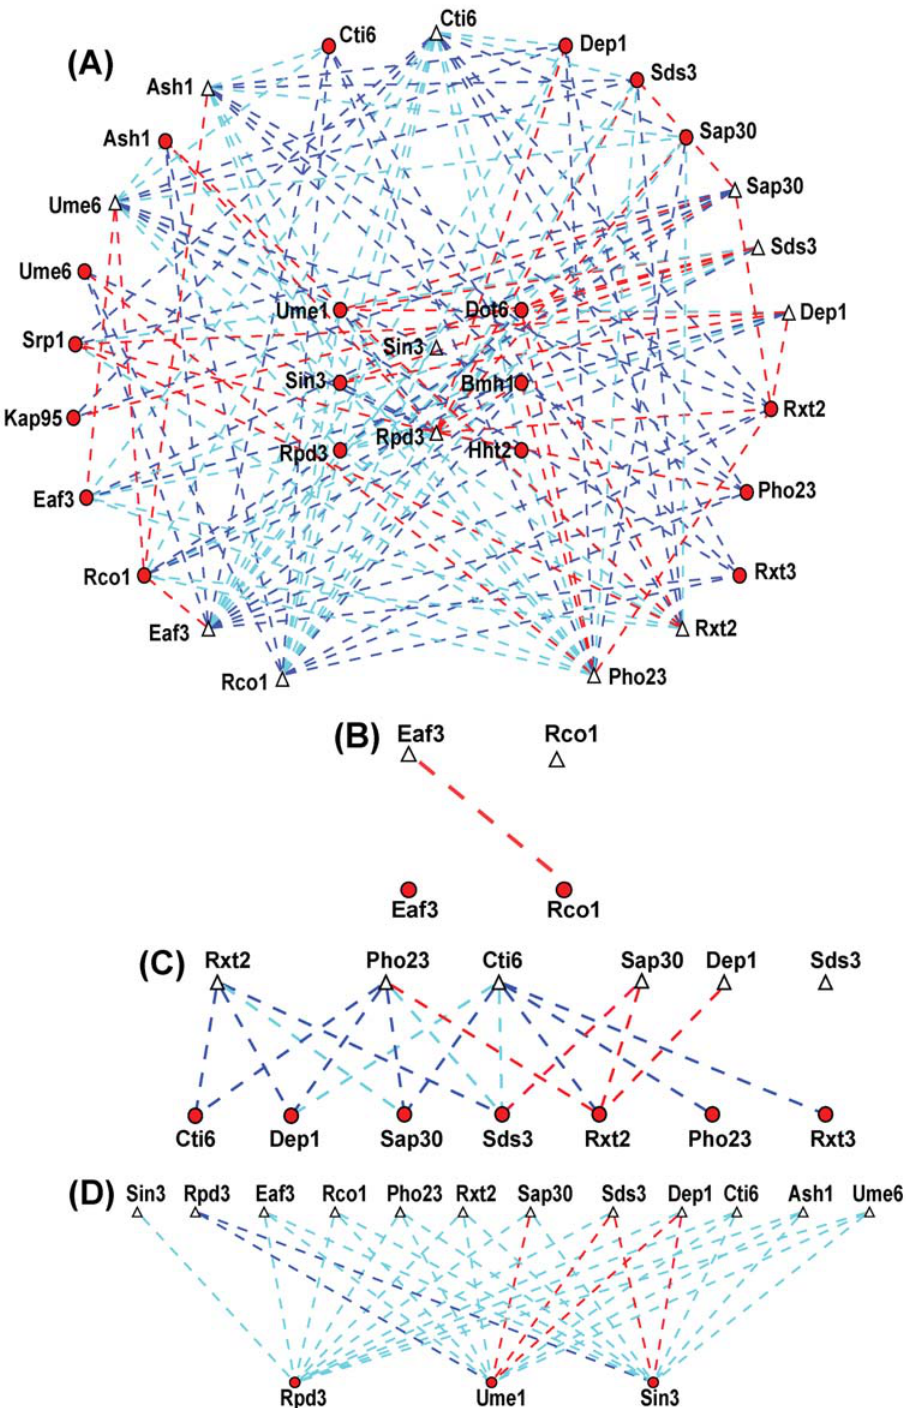
Figure 4. Probabilistic deletion network of the Rpd3 complexes. (A) The probabilistic protein network of the RPD3 complexes is generated by representing proteins as nodes (Rpd3-TAP in a deleted subunit are depicted by triangles and preys as circles), connected by weighted edges denoting the calculated probabilities. Blue dashed lines symbolize interactions with high probability, cyan dashed lines interactions with moderate probability, and red dashed lines interactions with low probability. (B–D) Focused probabilistic protein networks of the small complex (B), the shared module (C), and the large complex (D). Weighted edges are color-coded as in A. The Cytoscape software environment [33] was used to generate the probabilistic protein networks. For the visualization purpose, only the components of the complexes along with Srp1, Kap95, Hht2, Bmh1 and Dot6 were retained.